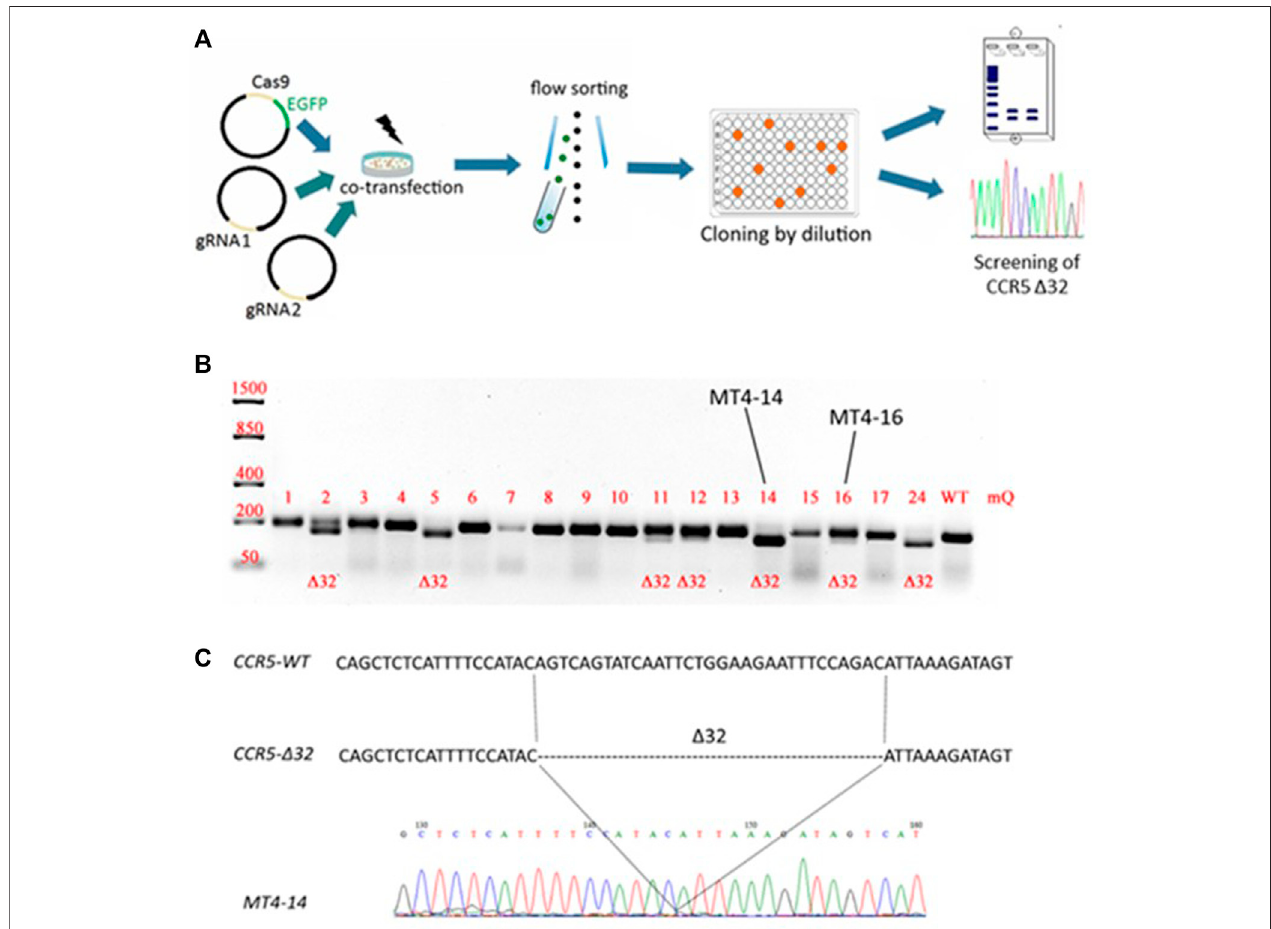
FIGURE 1 | Generation of an MT4 cell line with an arti fi cial CCR5 Δ 32 mutation using the CRISPR/Cas9 system (A) Experimental design (B) Analysis of the CCR5 locus containing the Δ 32 mutation in the obtained clones. The CRISPR targeted CCR5 locuswasPCR ampli fi ed from MT4 genomic DNA and PCR products were size- separatedbyelectrophoresisona2%agarosegel.Theexpectedampliconsizeis191-bpforWTsamples,and159-bpforCCR5 Δ 32samples (C) Sangersequencingof PCR amplicon of MT4-14 clone containing the 32 bp deletion in the CCR5